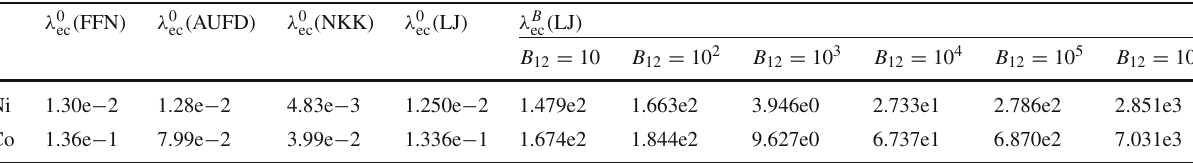
Table 3 Comparisons of the rates of FFN [2] ( λ 0 ec ( FFN ) ), AUFD [6] ( λ 0 ec ( AUFD ) ), NKK [9] ( λ 0 ec ( NKK )) , and our rates ( λ 0 ec ( LJ )) , which are in the case without SMFs with those of ours λ B ec ( LJ ) in the case with SMFs for ρ 7 = 5 . 86 , Y e = 0 . 47 , T 9 = 3 . 40,